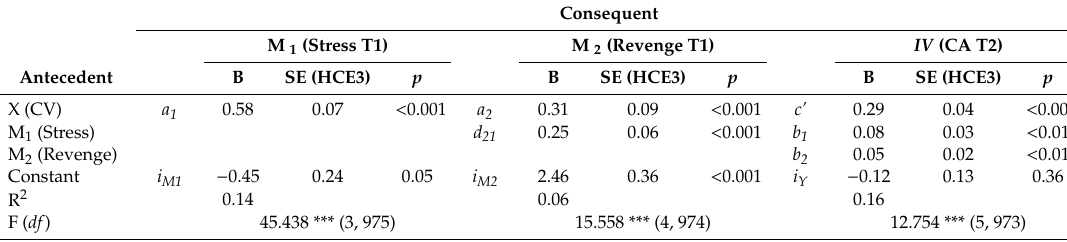
Table 2. Regression coe ffi cients, standard errors, and model summary information for stress and revenge as